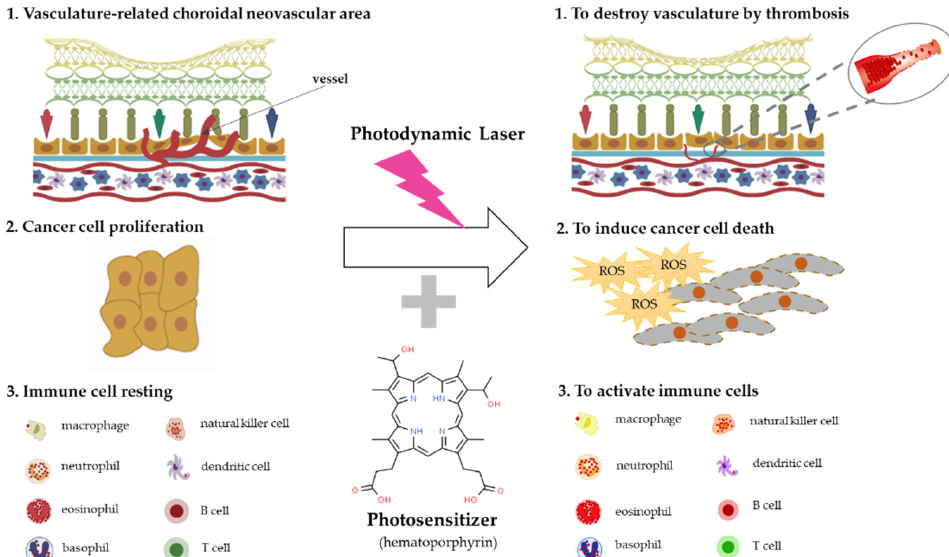
Figure 2. The mechanisms of photodynamic therapy. Photodynamic therapy generates reactive oxygen species (ROS) and destroys photosensitizer-binding fast proliferative cells, such as choroidal neovascularization (CNV) cells related to AMD via thrombosis and cancer cells through ROS synthe- sis, and stimulates immune cells’ activation.